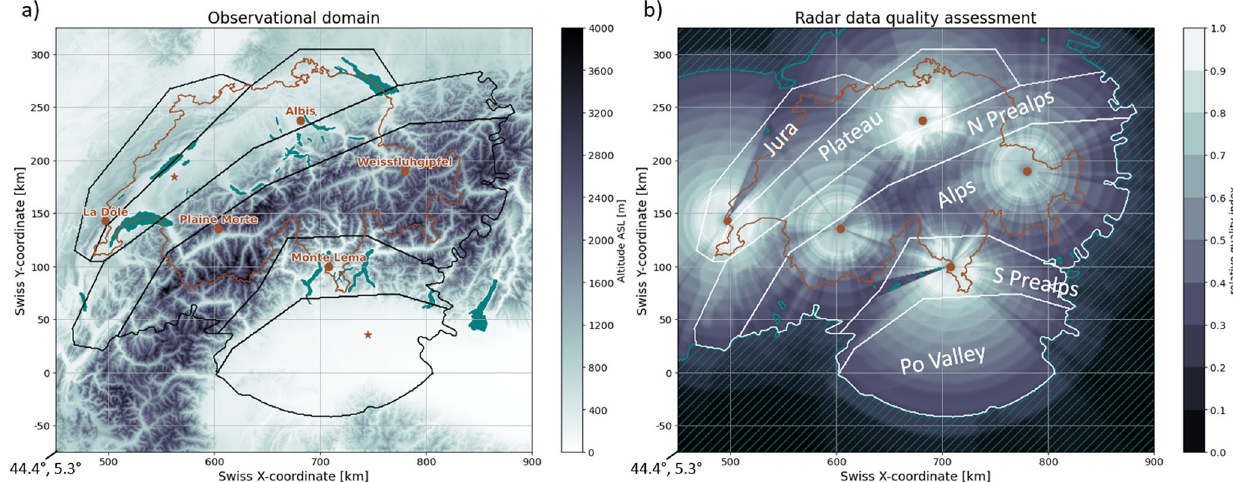
Fig. 1 Topography and data quality in the observational domain. a Radar domain and regional split, underlain with topographical elevation map (Digital elevation model from refs. 99 and 100 ), as well as site of the fi ve radars in Switzerland (dots) and two sounding sites (stars); b relative quality index of radar observations for convective phenomena 29 and regional split with regions' names. Table 1. Description of